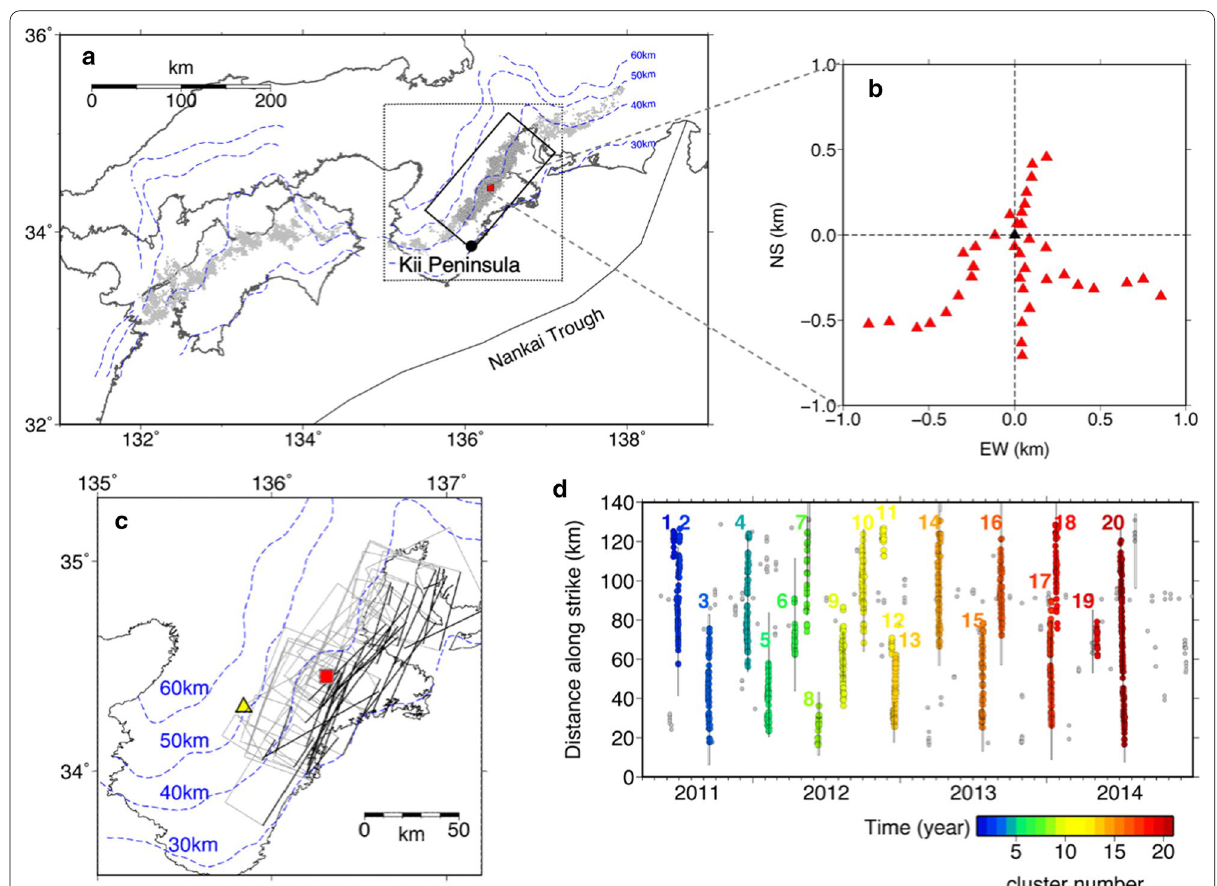
Fig. 1 a Location map of southwestern Japan showing the study area (black rectangle; Figs. 5, 6, 7, 8) and the array network (red square). Gray dots are tremor hypocenters from the NIED hybrid clustering catalog. Contour lines represent the depth of the Moho in the subducting Philippine Sea plate (Shiomi et al. 2008). Dotted square represents the area shown in ( c ). b Configuration of stations (triangles) in the seismic array. The black triangle is the central station. c The distribution of short-term SSEs detected geodetically by GSJ and/or NIED during the study period. Gray rectangles are surface projections of areas on the fault planes of the short-term SSEs; the black side of each rectangle is the up-dip edge. Yellow triangle represents a Hi-net station (KRTH) for which tilt data are shown in Fig. 4b. d Space–time plot of tectonic tremors from the NIED hybrid clustering catalog. Distance along strike or along dip is measured from the corner with a black circle of the black rectangle in ( a ). Circles represent hypocenters of tremor clusters for different ETS events analyzed in this study, colored according to their ETS number. ETS events 1, 8, and 11 were excluded from further analysis. Gray dots are tremor hypocenters that are isolated or belong to small ETS events. Gray vertical bars represent short-term SSEs detected geodetically by